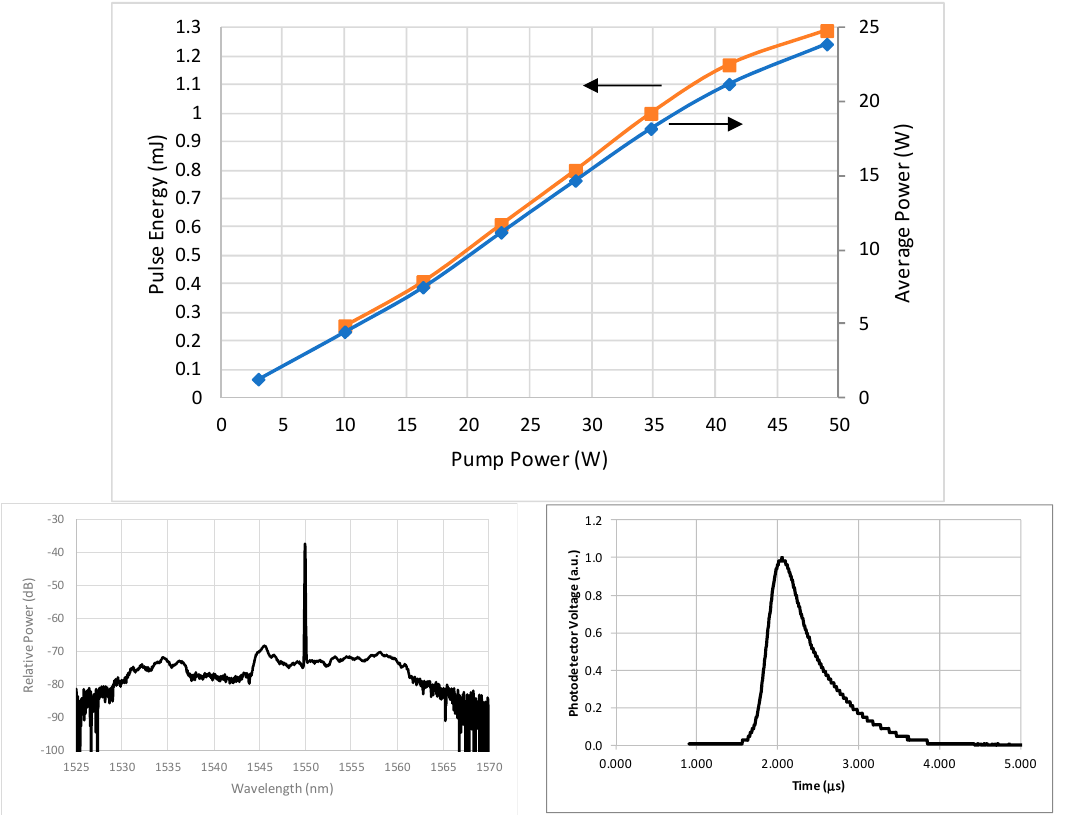
Figure 2. Energy and Average Power vs. pump power, optical spectrum, and pulse shape at 1.3 mJ and 18 kHz with 600 ns pulses.